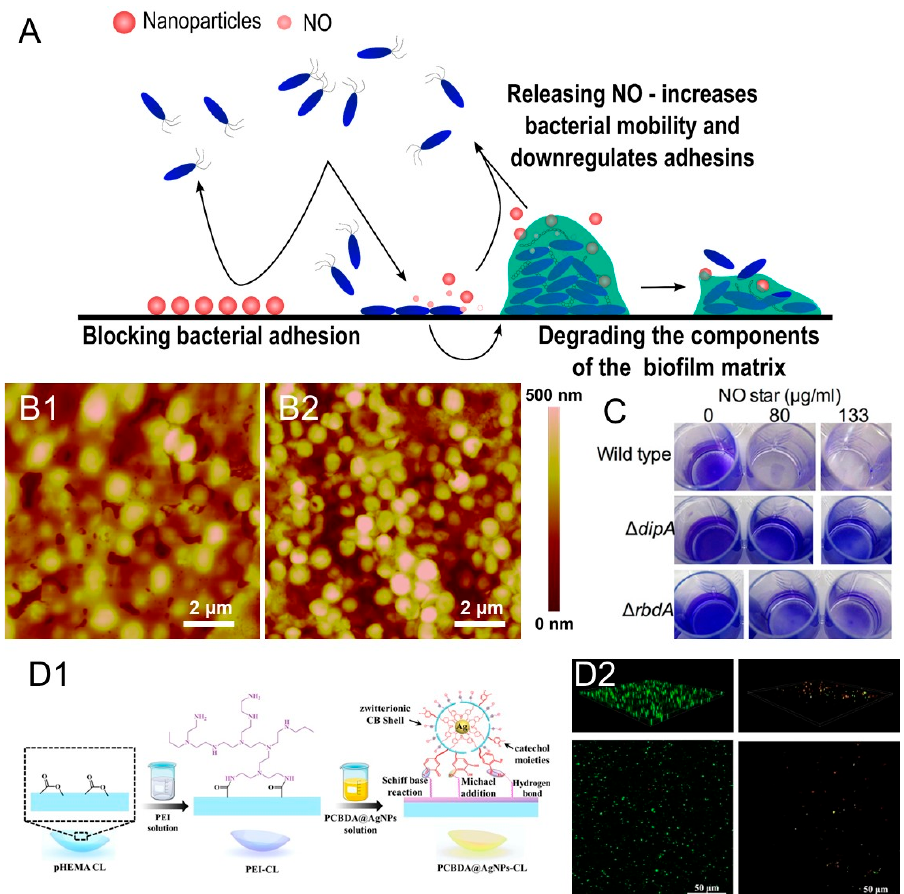
Figure 2. ( A ) Schematic representation of the anti-adhesive and biofilm-dispersing strategies cov- ered in this review. ( B ) Nanoaggregates of Ag-amylase degraded EPM of S. aureus biofilm on gold disks. AFM images of the disk showing EPM matrix ( B1 ) and its disintegration by the hybrid Ag- amylase NPs ( B2 ) (reproduced from [34] under the terms of the Creative Commons Attribution In- ternational License (CC BY 4.0)). ( C ) Cristal violet staining of P. aeruginosa biofilms treated with different concentrations of NO-core cross-linked star (Adapted with permission from Duong et al .,